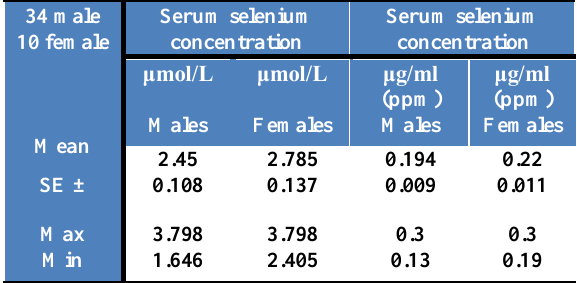
Table, 2: The mean and range of serum selenium concentration in males and females cats.